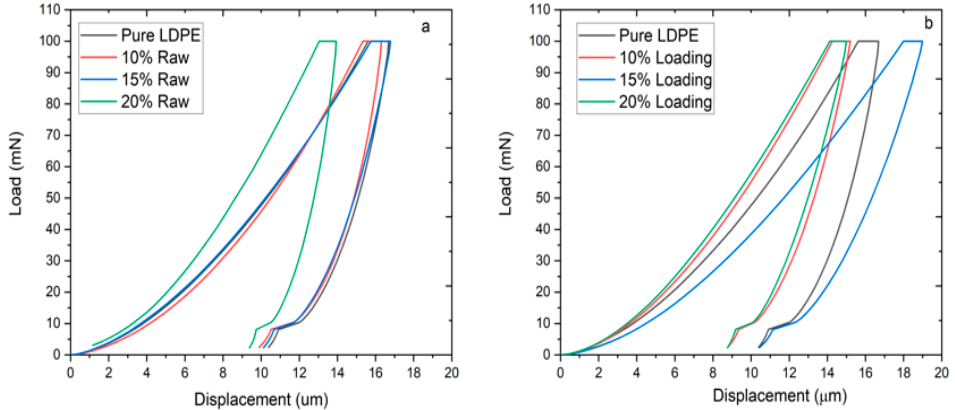
Figure 2. The contact compliance curves of pure LDPE and the biocomposites reinforced with ( a ) raw RHW and ( b ) ChCl pretreated RHW with different loadings (10, 15, and 20 wt.%) at a peak load of 100 mN.